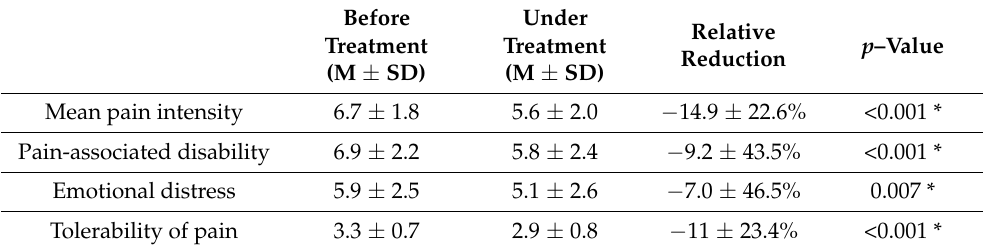
Table 2. Change in pain intensity, physical disability, pain tolerability and emotional distress before and after starting cannabinoid